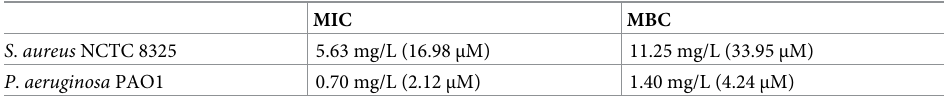
Table 1. Determination of minimum inhibitory concentrations (MICs) and minimum bactericidal concentrations (MBCs) of